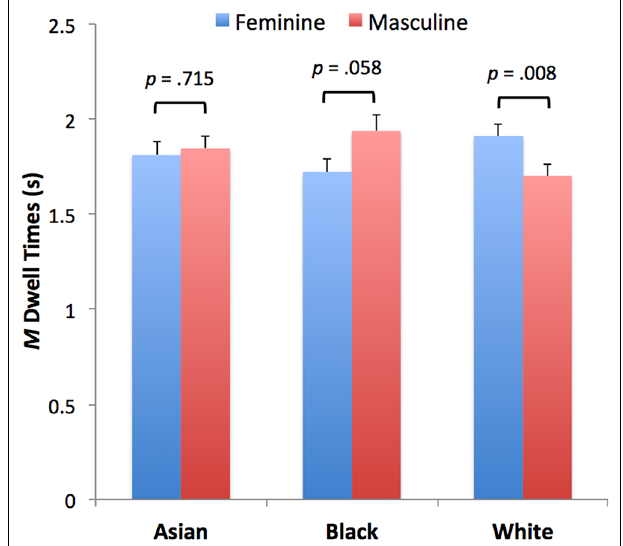
FIGURE 2 | Dwell times toward feminine vs. masculine faces in Asian, Black, and White face pairs. Error bars = SEM.